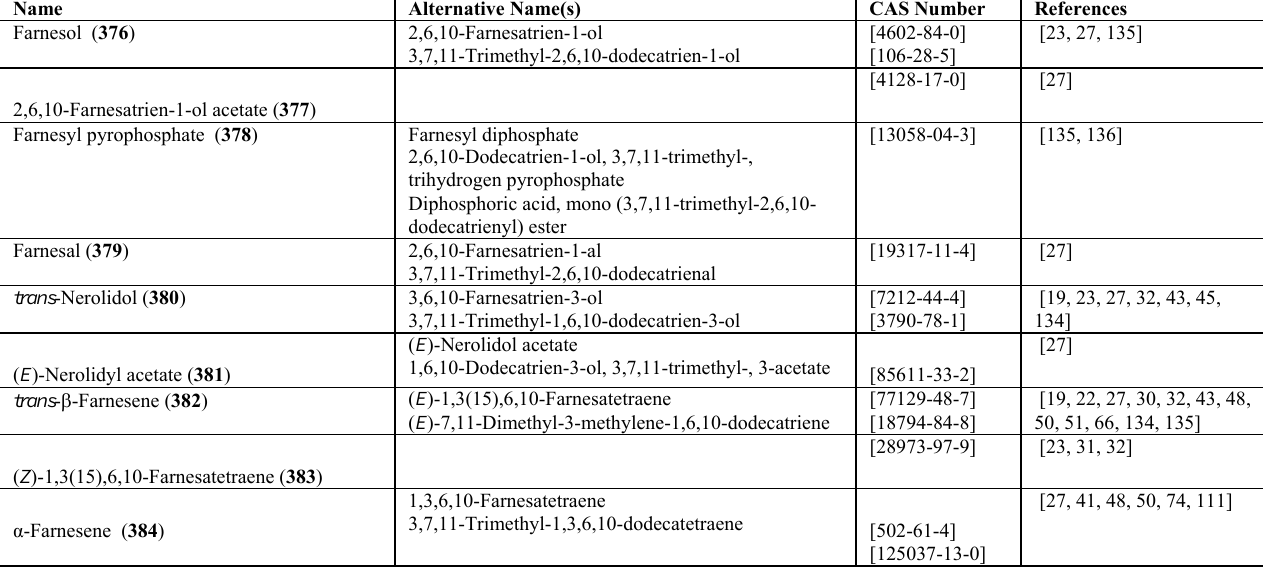
Table 29. Farnesane Sesquiterpenoids (2,6,10-Trimethyldodecane,